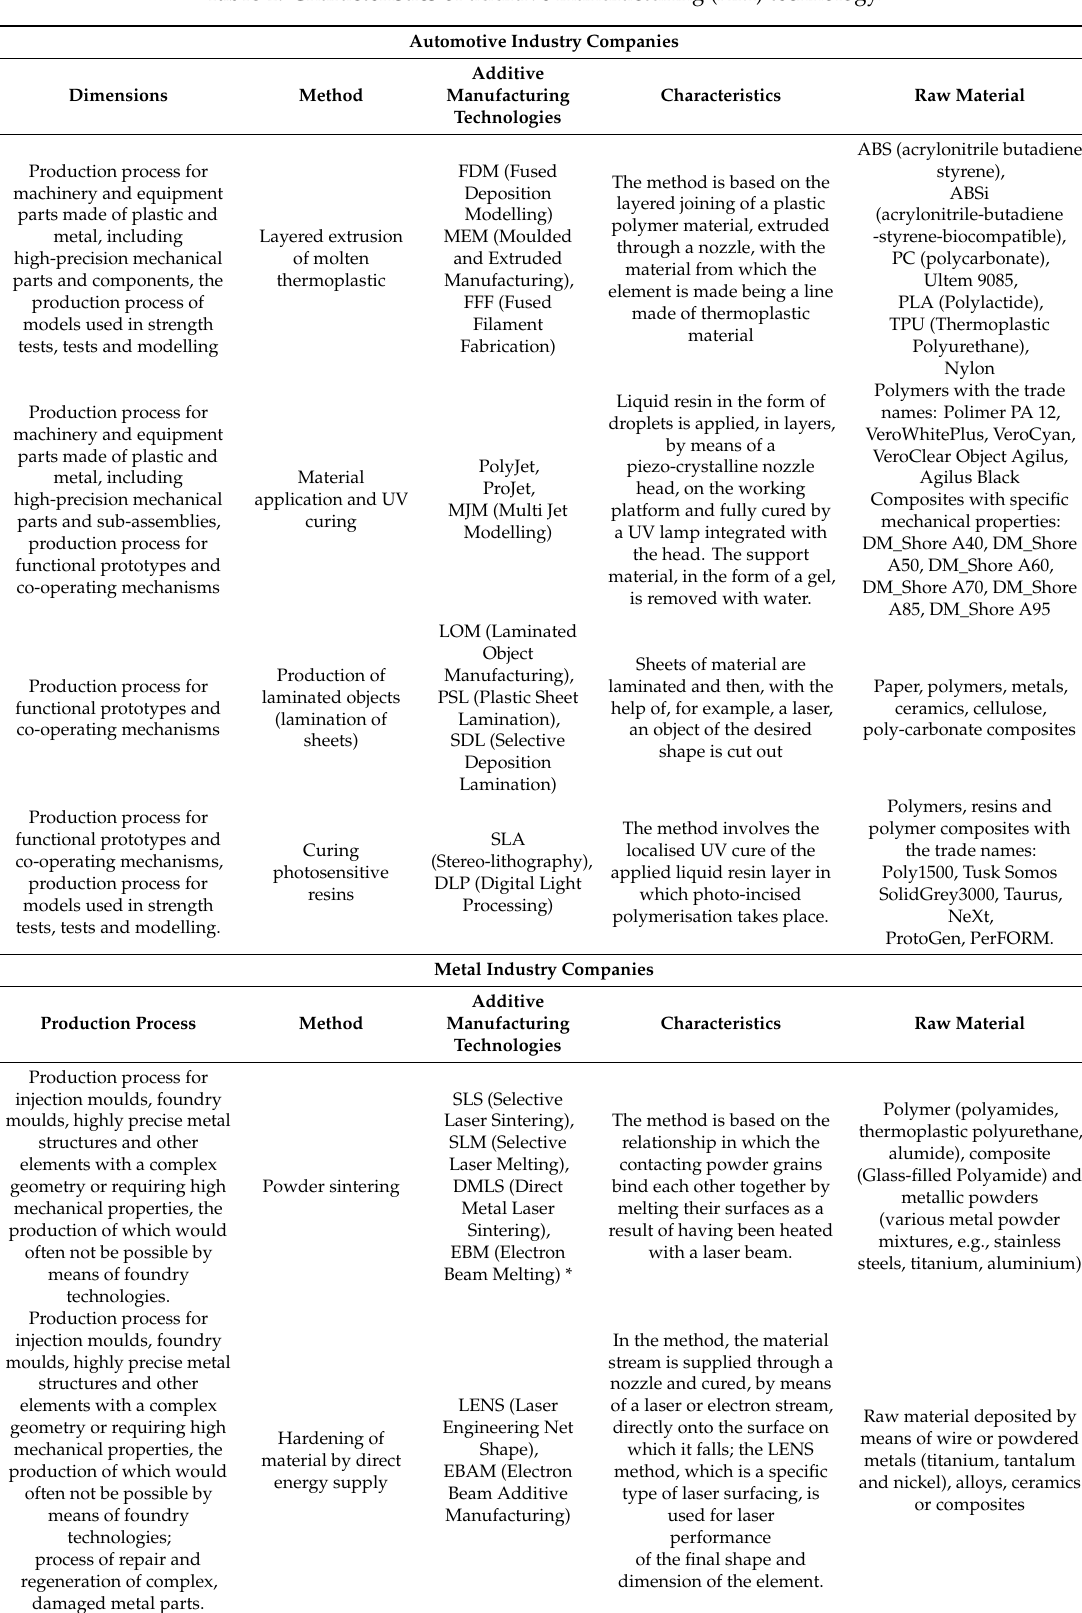
Table 1. Characteristics of additive manufacturing (AM)